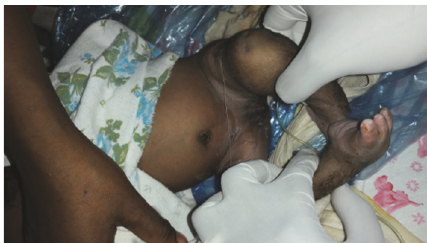
Figure 4: Picture of the newborn after successful reduction of the